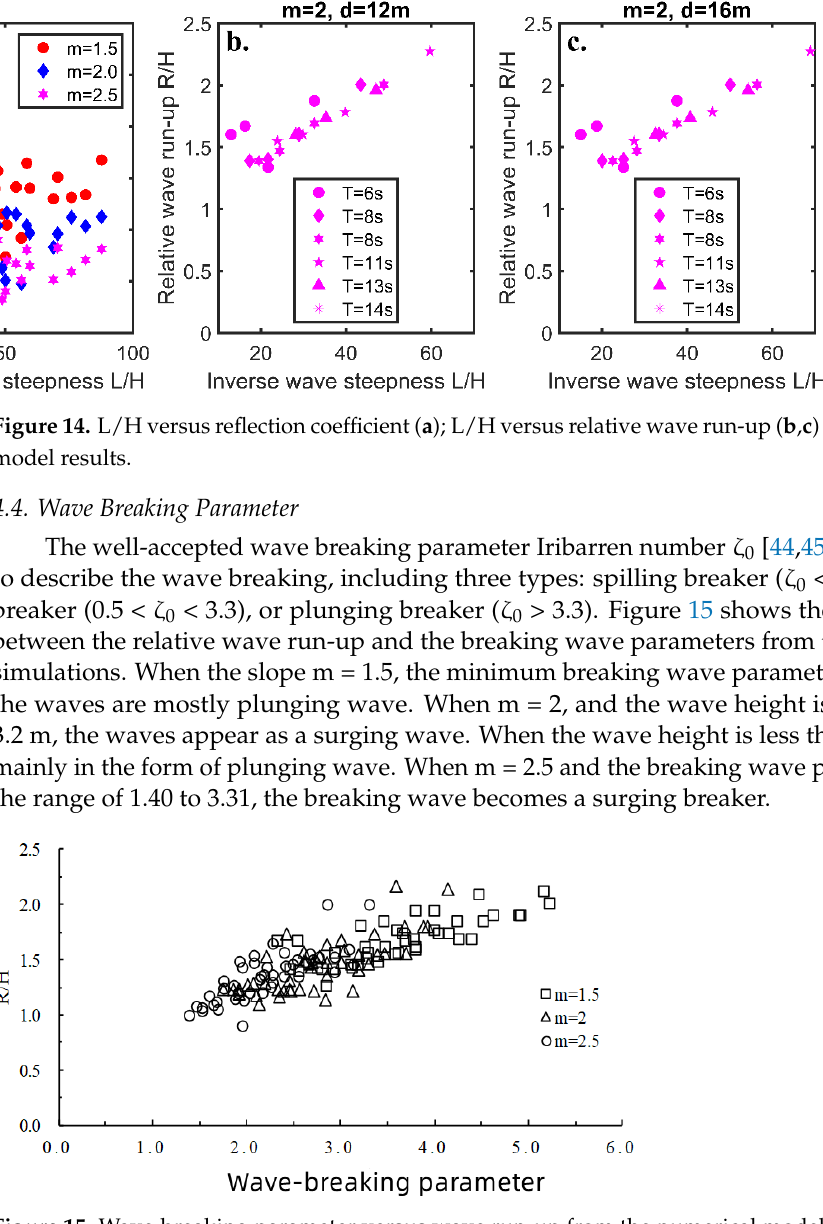
Figure 15. Wave-breaking parameter versus wave run-up from the numerical model results.